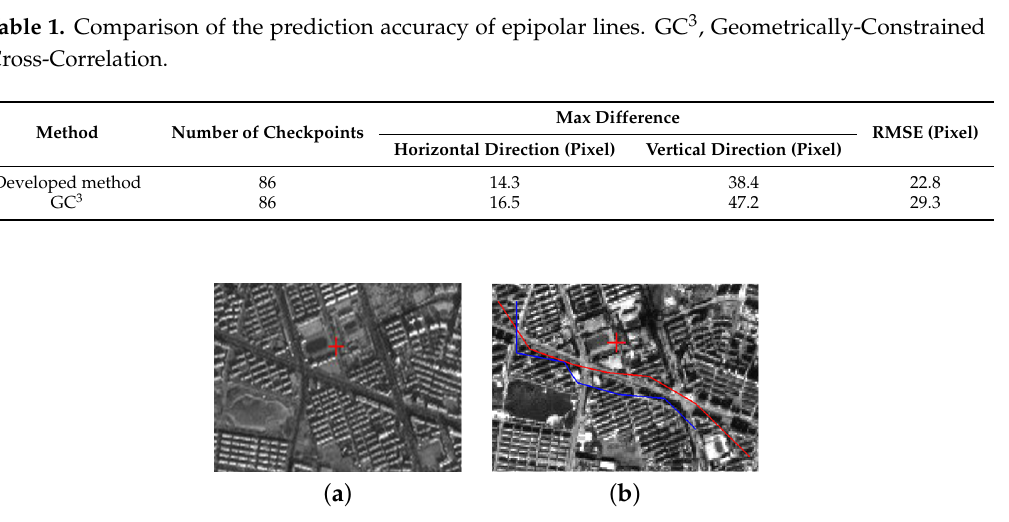
Figure 6. Epipolar lines generated by GC 3 and the developed method: ( a ) a checkpoint on the test image; ( b ) zoomed view of epipolar lines; the red one is generated by the developed method, and the blue one is generated by GC 3